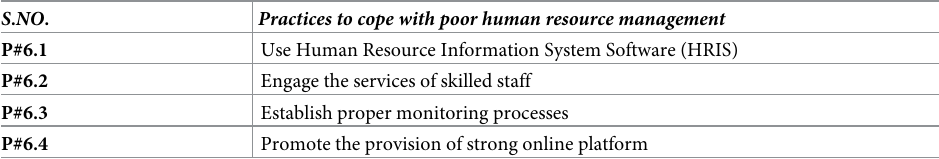
Table 9. Practices to cope with poor human resource management in COR.